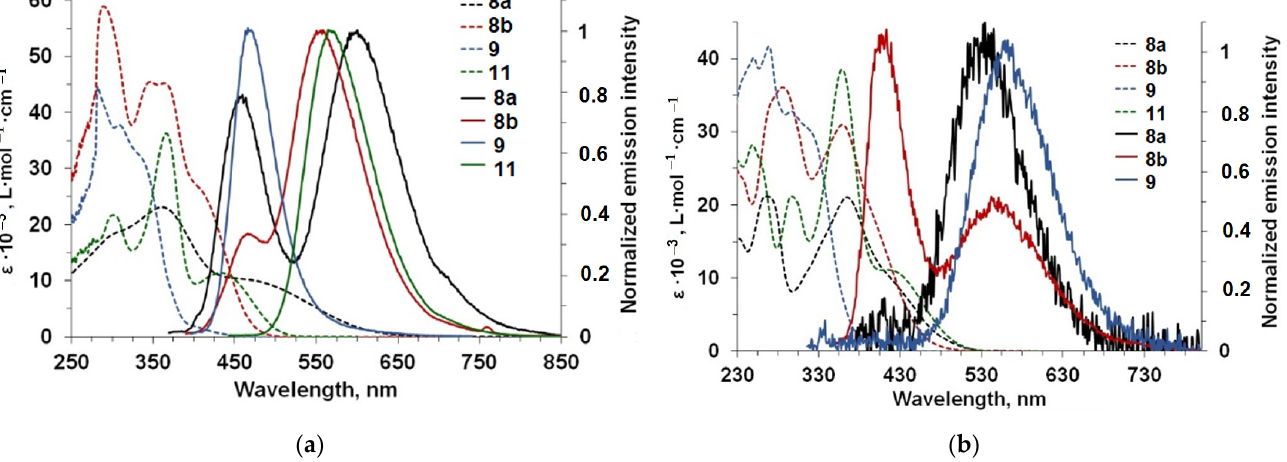
Figure 5. UV/Vis (dashed line) and photoluminescence (solid line) spectra of 4-cyano-derivatives 8a,b , 9 and 11 in toluene ( a ) and MeCN ( b ).